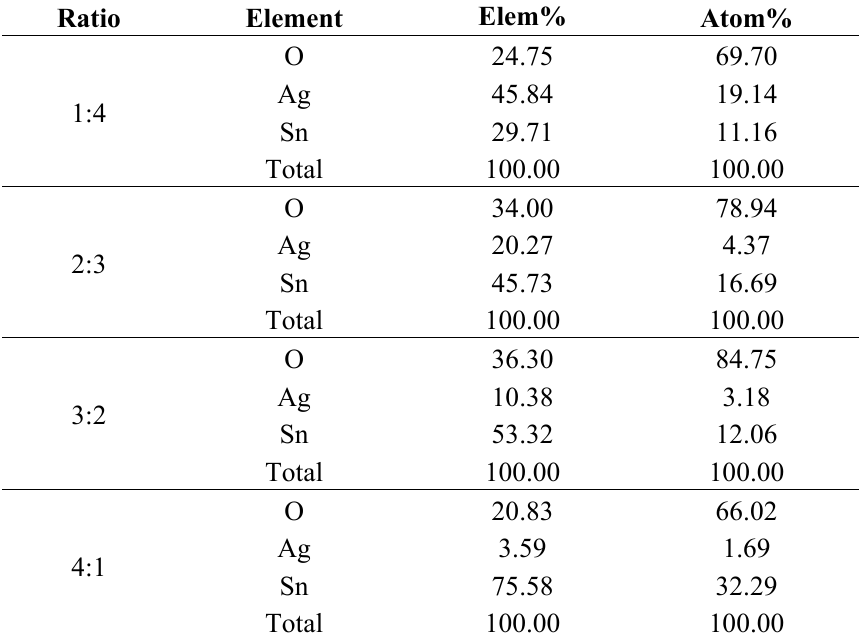
Table 1. Energy-dispersive X-ray spectroscopy (EDX) analysis of SnO at 1:4 mixture, 2:3 mixture, 3:2 mixture, and 4:1